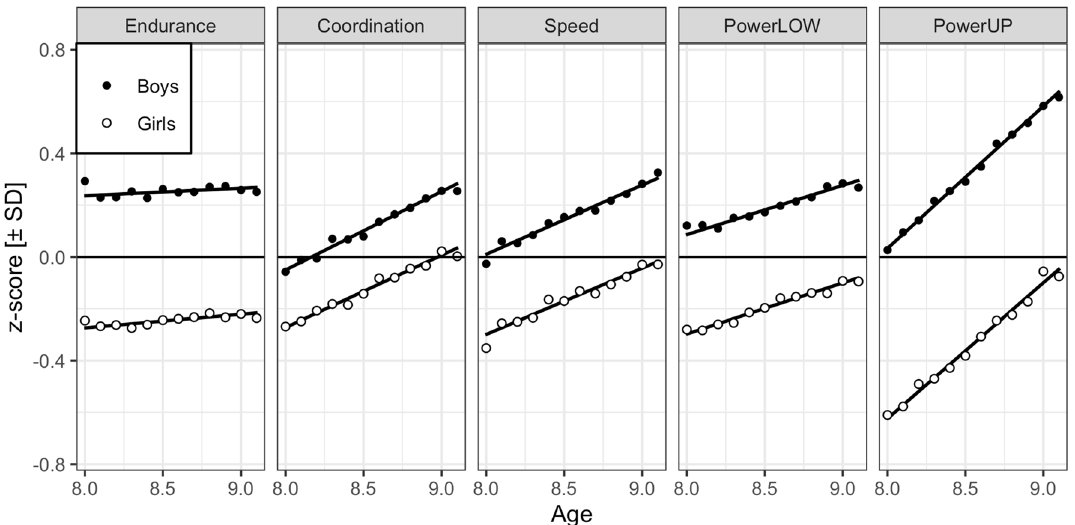
Figure 2. Performance differences between 8.0 und 9.0 years by sex in the five physical fitness tests presented as z-transformed data computed separately for each test. Endurance = cardiorespiratory endurance (i.e., 6 min run test), Coordination = star run test, Speed = 20-m linear sprint test, PowerLOW = power of lower limbs (i.e., standing long jump test), PowerUP = power of upper limbs (i.e., ball push test), SD = standard deviation. Points are binned observed child means; lines are simple regression fits to the observations; 95% confidence intervals for means ≈ 0.05 are not